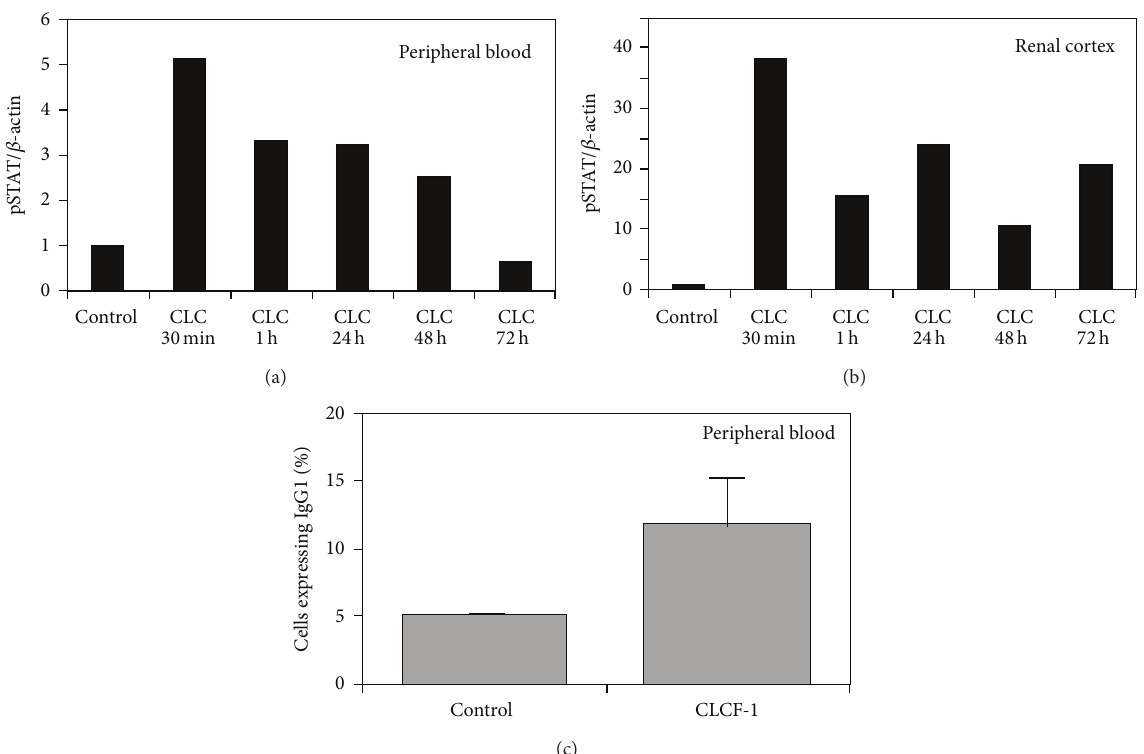
Figure 2: Total pSTAT3 in (a) peripheral blood cells and (b) renal cortex was determined by Western blot analysis of lysates as described in Methods and Materials. Values are expressed as the ratio of pSTAT to 𝛽 -actin. Results of a single experiment are shown. Note that the maximum increase in pSTAT3 is nearly 8-fold greater in kidney cortex compared to blood cells. (c) Mouse spleen mononuclear cells were isolated and analyzed as described in Methods and Materials. Results are expressed as percentage of B cells expressing IgG1 (CD19+/IgG1+). Mean of 3 determinations in each of the 2 mice was used to calculate values, expressed as mean ± standard deviation. CD19+/IgG1+ cells were increased after infusion of CLCF-1. ∗ 𝑃 < 0.01 .